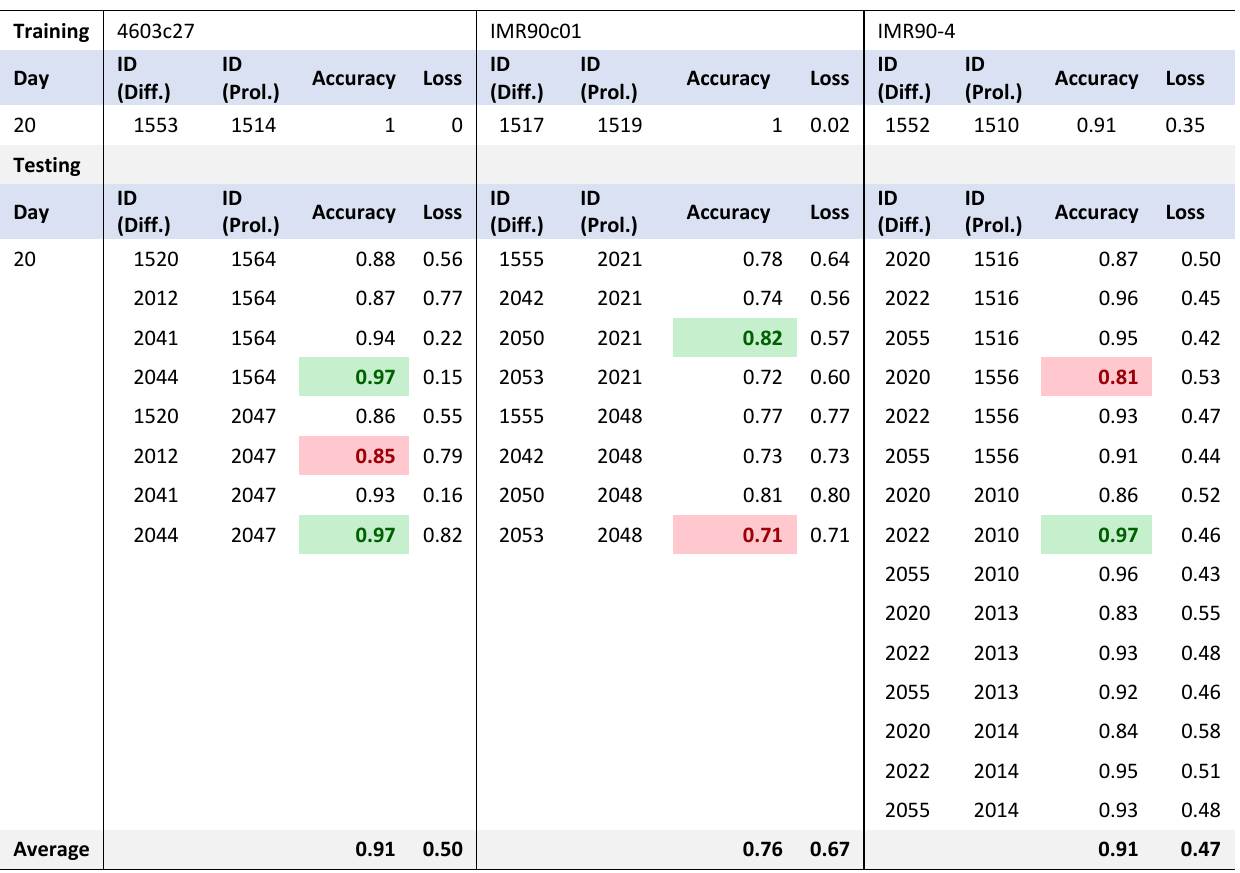
Table 1: Accuracy and loss data for both training and testing (day 20) for day 20 cell